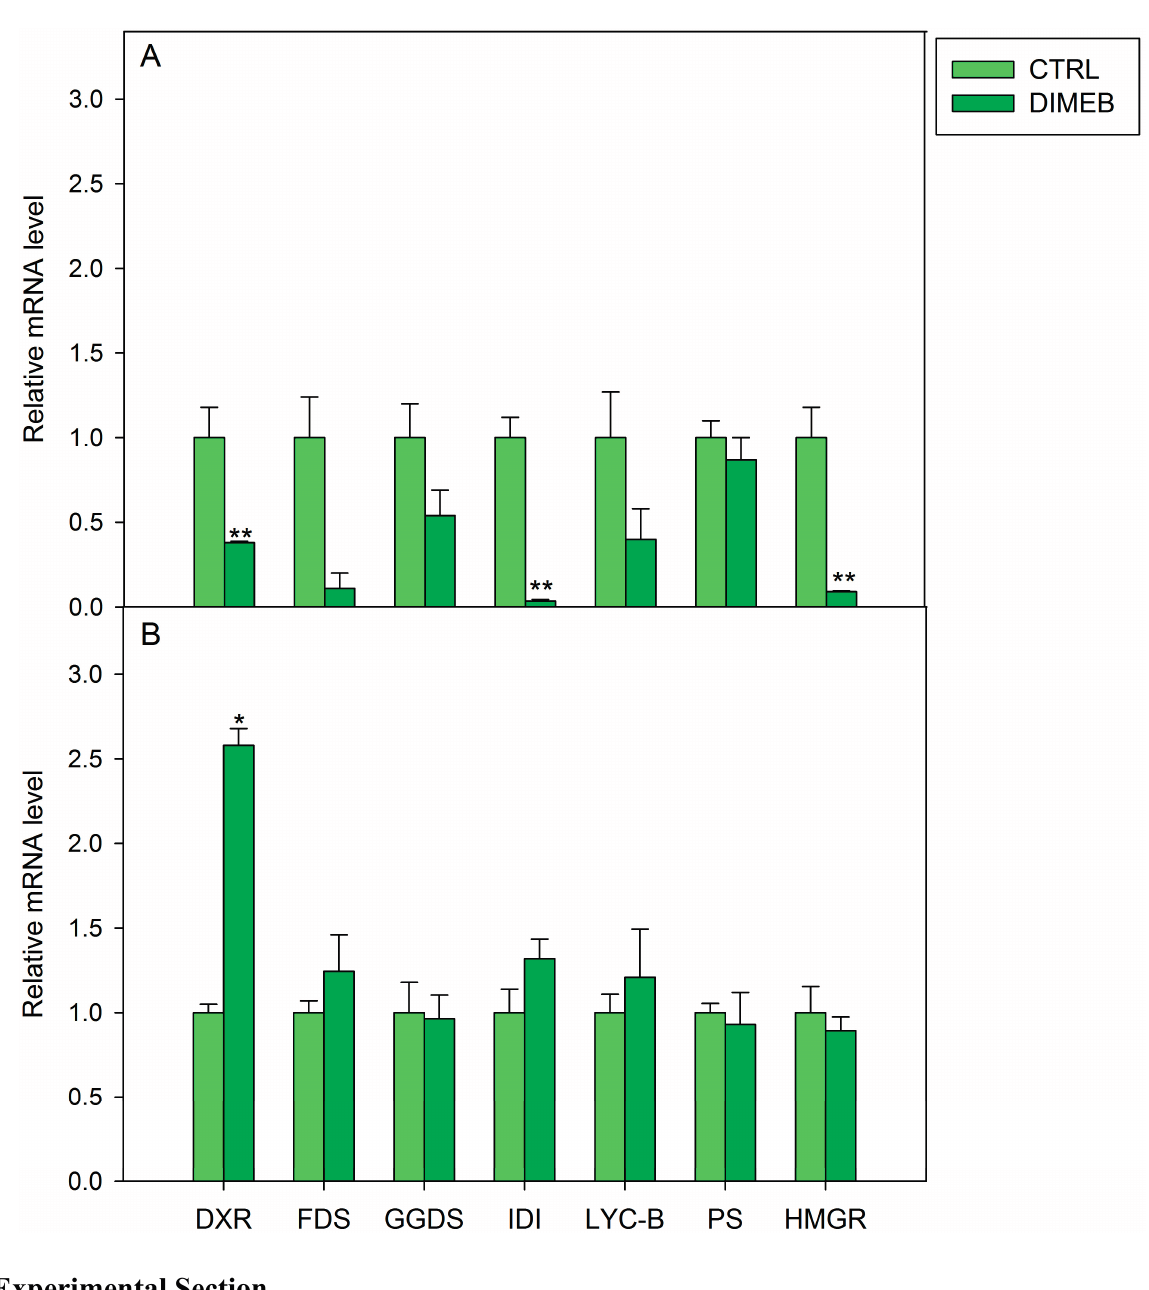
Figure 4. Relative mRNA level in A. annua cell cultures untreated (CTRL) or treated (DIMEB) with 50 mM DIMEB for one ( A ) and three ( B ) days. Data are expressed as mean ± standard deviation from three independent experiments, * p < 0.05; ** p < 0.01 in comparison with control assessed by Anova-one-way post hoc Holm-Sidak